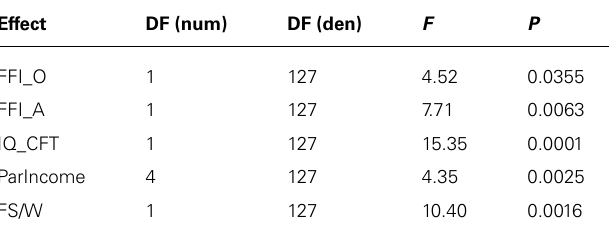
FIGURE 3 | Depicted are the relative risk aversions (RRA) of students in dependence on their source of funding (support by their families vs. other forms of funding, e.g., own work or grants). Using the simple unpaired two-tailed t -test the difference was statistically significant ( (cid:2) RRA = 0.22; 95% CI: 0.04–0.41; p =